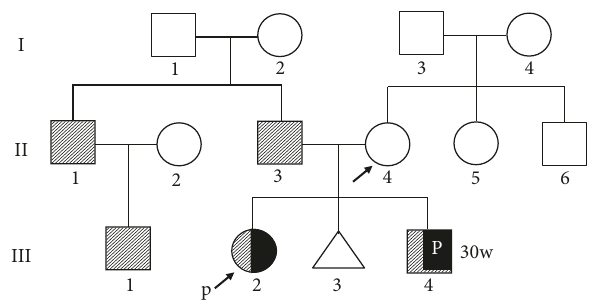
Figure 4: Pedigree of the family with familial CDH. Affected boy ( ◼ ) and girl ( e ), spontaneous abortion ( △ ), and SGA infant (lined square, lined circle) found in the paternal